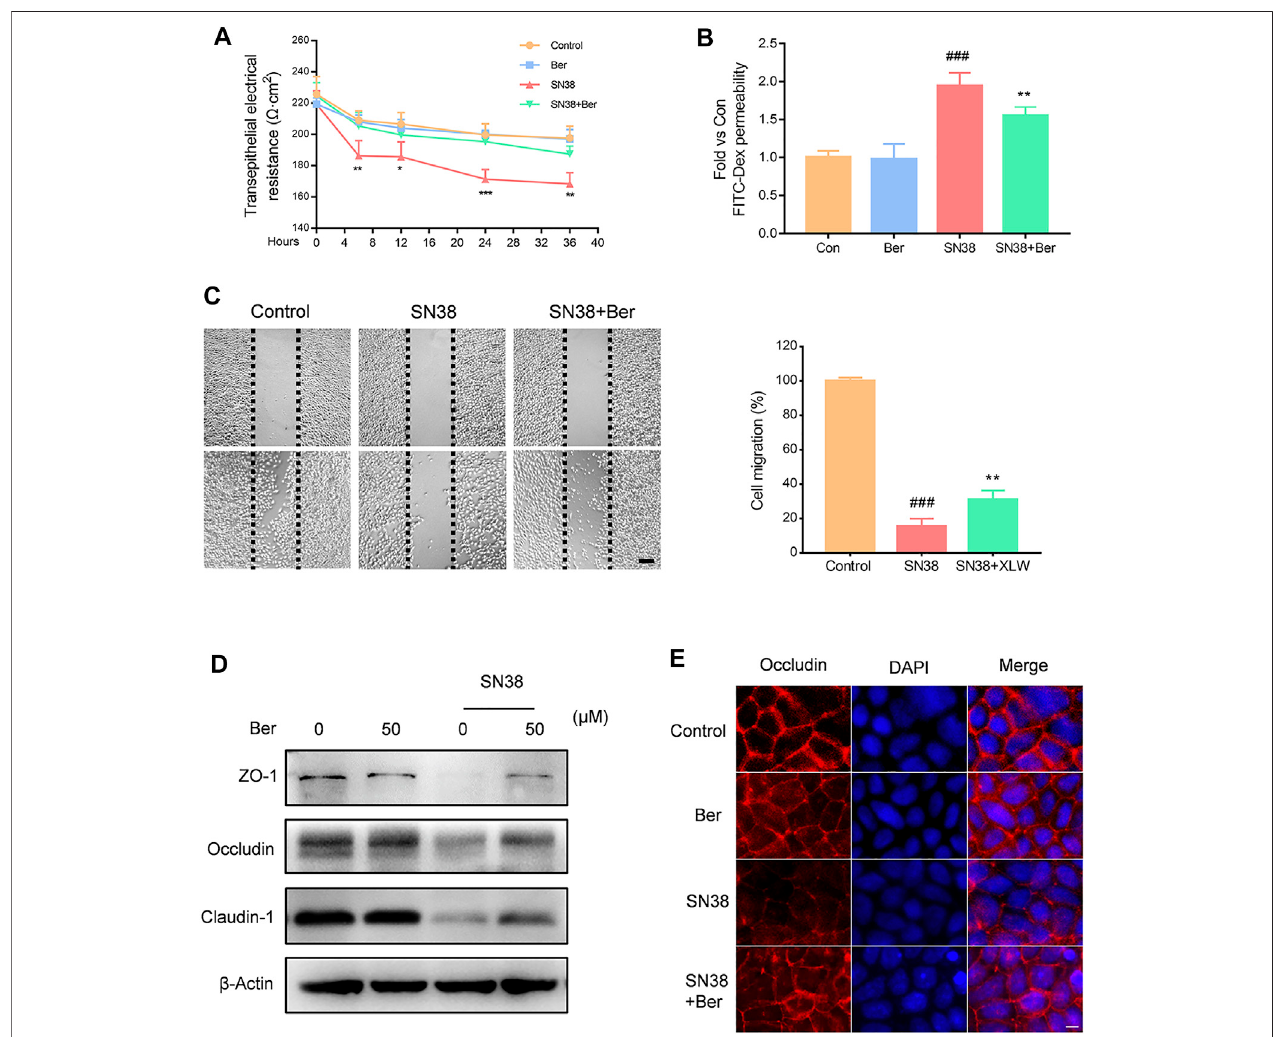
FIGURE 4 | Effect of berberine on SN38-induced disruption of barrier function in vitro . (A) NCM460 cell monolayers were treated with berberine (50 μ M), SN38 (250 nM) or SN38 (250 nM)) + Ber (50 μ M) for 4, 12, 24, and 36 h, respectively; then, we measured trans-endothelial electrical resistance (TEER). (B) The fl ux of 4 kDa FITC-dextran was measured by fl uorescence spectroscopy. (C) Representative images of scratch wound assays for NCM460 cell monolayers at 0 and 24 h after scratching. (D) The effect of berberine on the expression levels of tight junction proteins (ZO-1, Occludin, and Claudin-7) in NCM460 cells. (E) The expression of Occludin (red) was evaluated by immuno fl uorescence. Nuclei were stained with DAPI (blue). Data were expressed as the mean ± SD ( n (cid:2) 3 per group). ## p < 0.01, ### p < 0.001 vs. the control group; * p < 0.05, ** p < 0.01, *** p < 0.001 vs. CPT11 + berberine treated group.